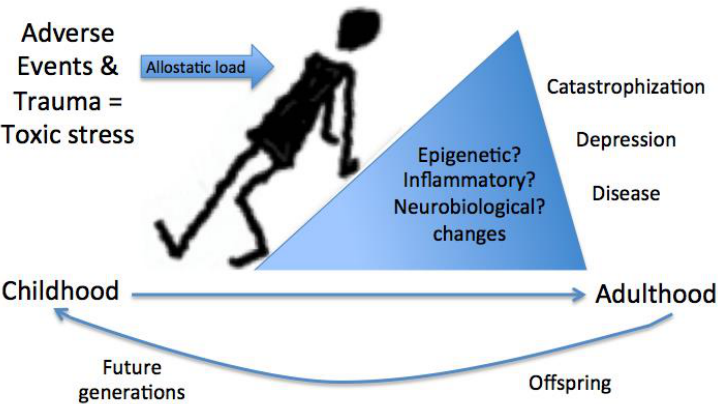
Figure 1. The impact of stress and trauma in childhood. Adverse childhood events, stress, and trauma contribute to toxic stress. Toxic stress that results from prolonged exposure to stress, aggregated trauma experiences, or incidents of significant emotional impact yields an increased allostatic load on the body. Allostatic load, measured by biological markers of disease risk including inflammatory cytokines, neurobiological changes, metabolic abnormalities, and epigenetic modifications, may carry over into future